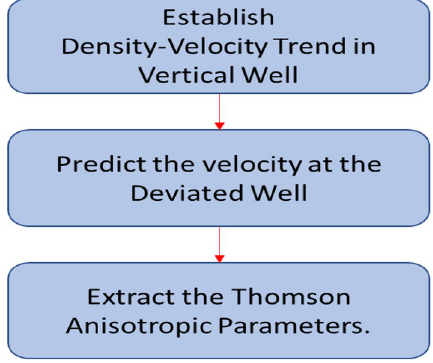
Fig. 1 Workflow to extract Thomsen’s anisotropic value from a devi- ated well